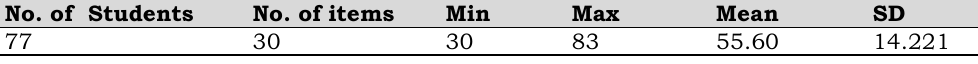
Table 3. Descriptive statistics of the reading comprehension